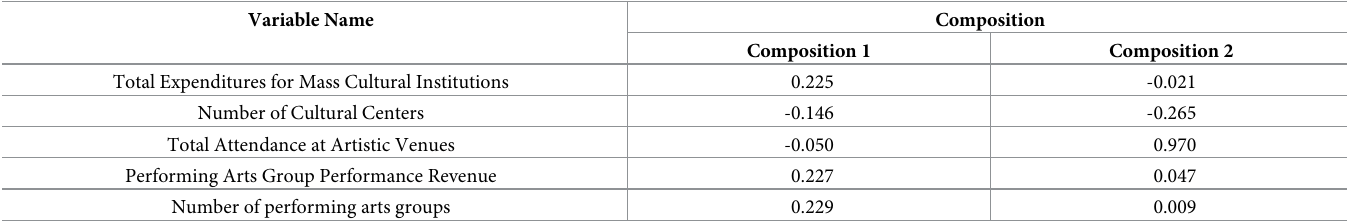
Table 5. Component score coefficient matrix.